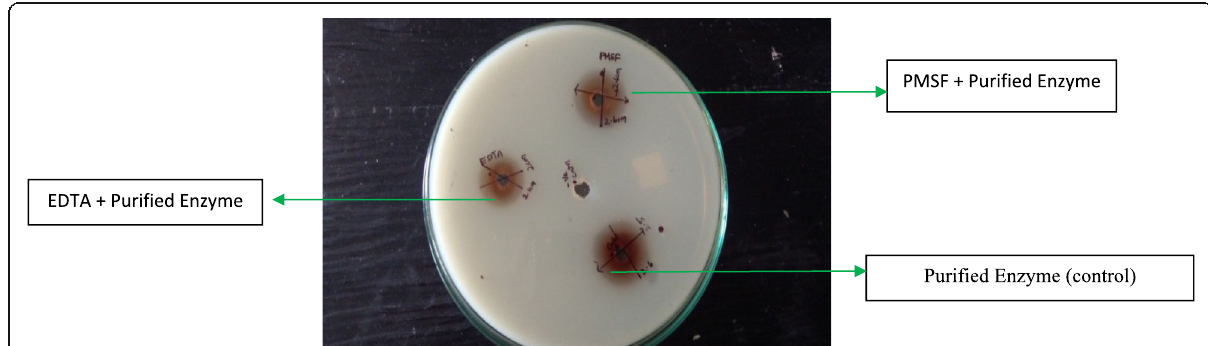
Fig. 7 Effect of various inhibitors on purified protease. The inhibitors ’ role was determined by measuring the casein hydrolytic zone after the pre- incubation of the enzyme with inhibitors. Control, purified enzyme without inhibitors; EDTA, ethylene diamine tetra acetic acid; PMSF, phenyl methyl sulfonyl fluoride